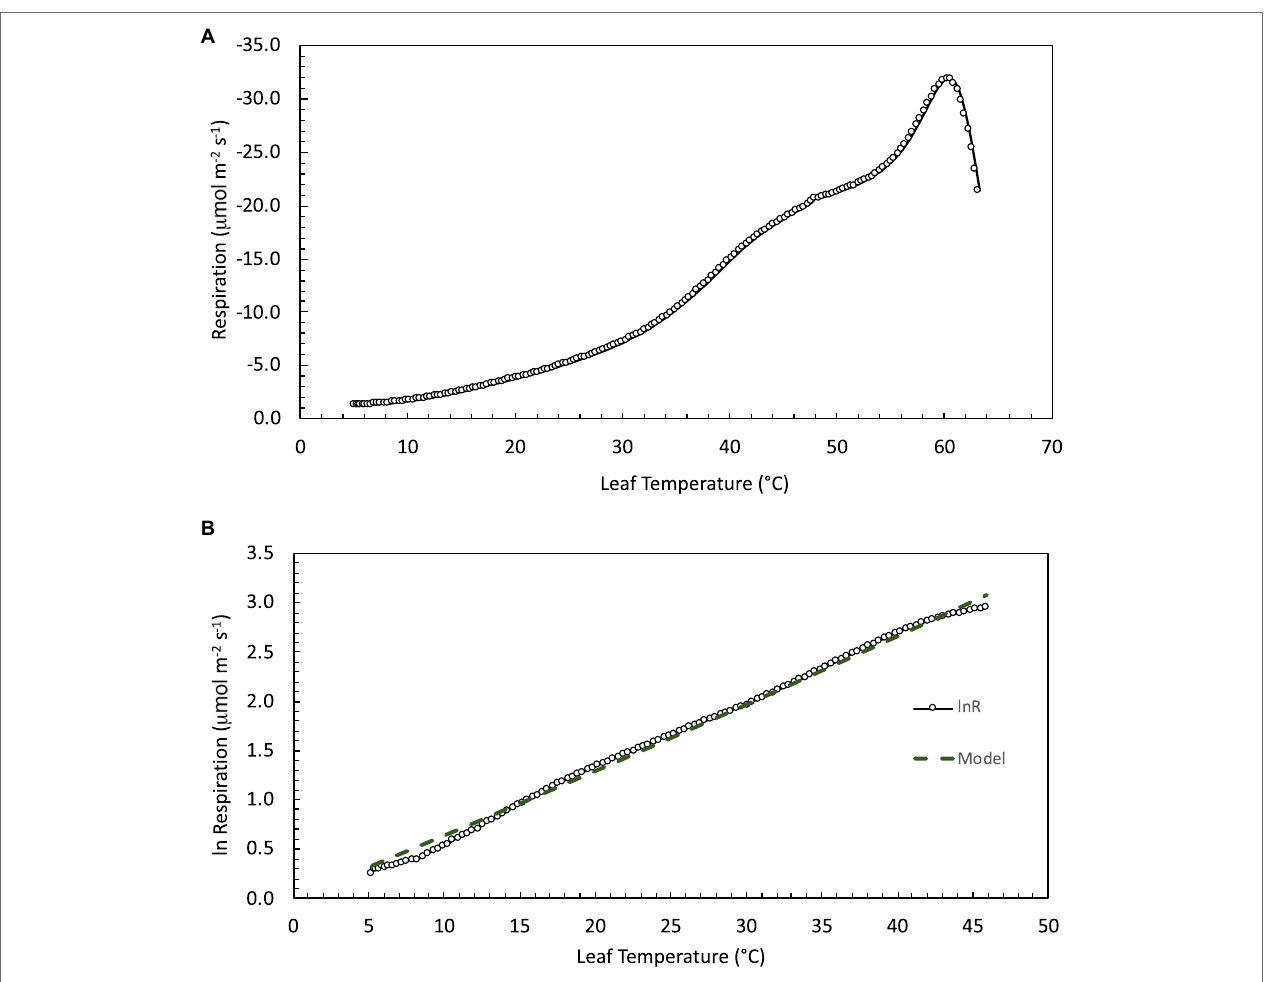
FIGURE 1 | Leaf respiration as a function of temperature in Picea glauca measured at the forest tundra ecotone (FTE) in Alaska. (A) An example of the high- resolution temperature response curves measured from 5 to 65 ° C. Air temperature was heated at a rate of 1 ° C min − 1 while the rate of CO 2 release and other gas- exchange parameters were recorded every 20 s. (B) The log of measured respiration rate and model fit ( lnR = a + bT + cT 2 – see text for full description) between 10 and 45 ° C (the ecologically relevant temperature range) for the same